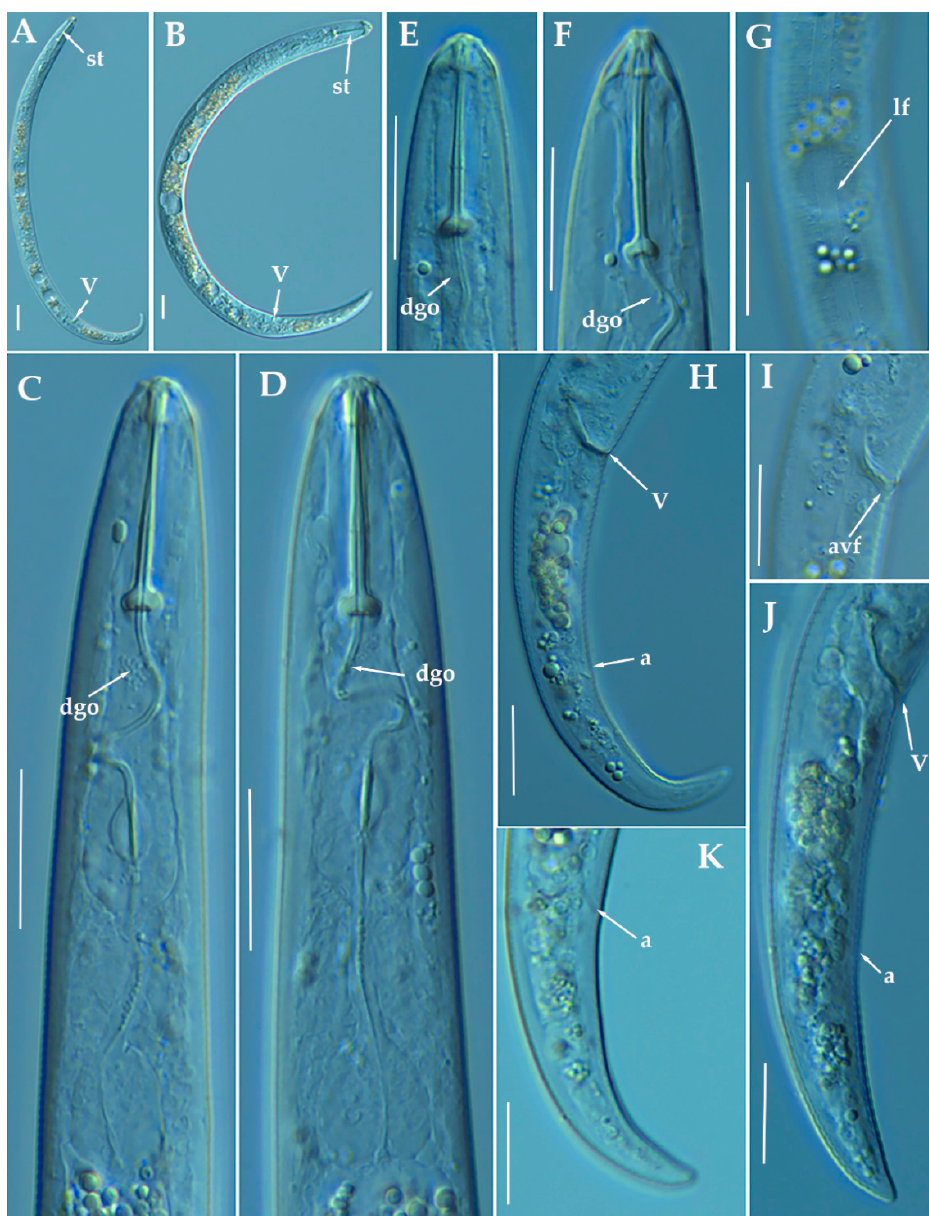
Figure 17. Light photomicrographs of Paratylenchus israelensis (Raski, 1973) Siddiqi, 1986. ( A , B ): Entire female with vulva arrowed; ( C , D ): Female pharyngeal region; ( E , F ): Female lip region; ( G ): Detail of lateral field at mid-body; ( H , J ): Female posterior region with vulva and anus (arrowed); ( I ): Detail of vulva showing advulval flap (arrowed); ( K ): Detail of female tail tip with anus arrowed. Scale bars ( A – K = 20 μ m). (Abbreviations: a= anus; avf = advulval flap; dgo = pharyngeal dorsal gland orifice; lf= lateral field; V= vulva).